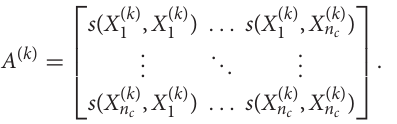
between pairs of the windowed times series for